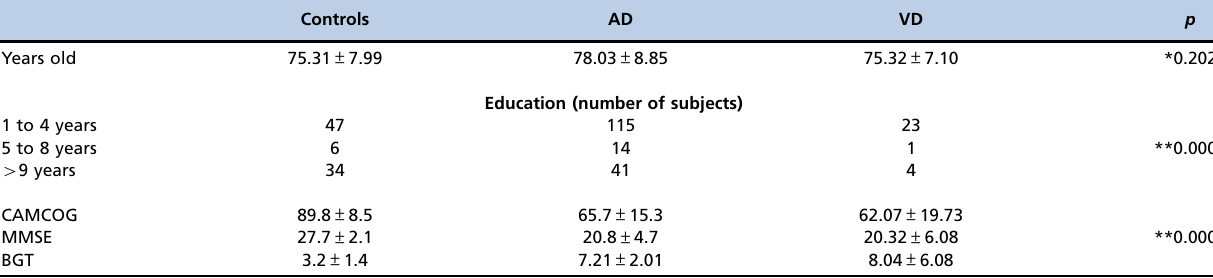
Table 1 - Characteristics of the sample according to age, sex and schooling.